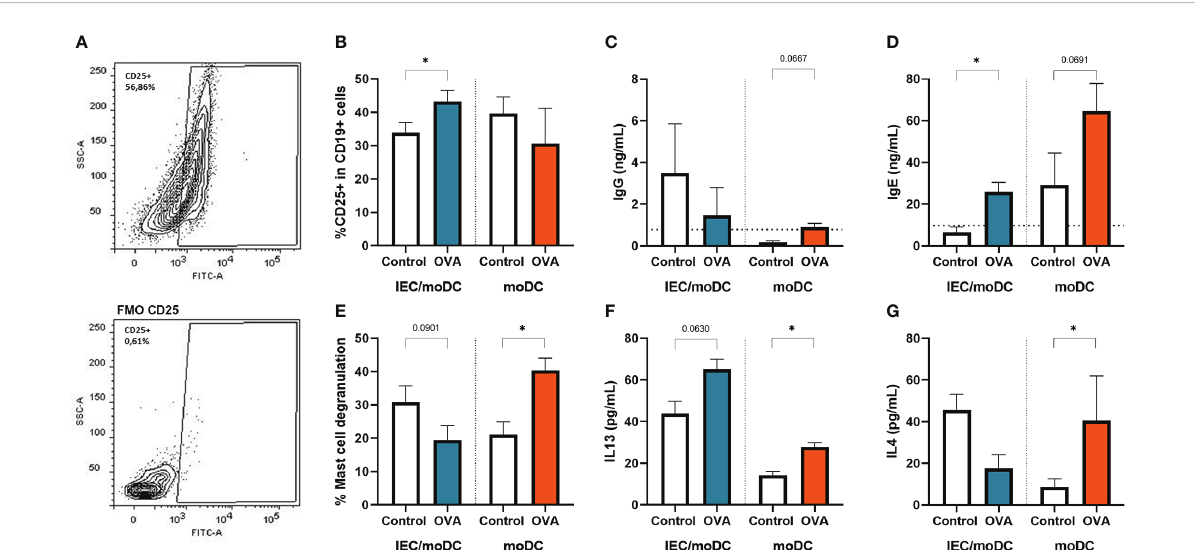
FIGURE 5 After the T cells were cocultured with OVA primed IEC-moDC or OVA primed moDC, subsequently the primed T-cells were cocultured with autologous naïve B cells. Activation of B cells was assessed at day 4 by fl ow cytometric analysis of expression of CD25, (A) a representative sample and appropriate FMO control are shown. (B) Percentage of CD25 expressing B cells are displayed for the used conditions. Secretion of (C) IgG and (D) IgE was determined in the supernatant after 18 days of coculture. These cell free 18 day supernatants were also overnight incubated with primary human mast cells. (E) Degranulation upon crosslinking with anti-IgE was determined by means of beta-hexosaminidase release as well as overnight (F) IL13, and (G) IL4 secretion by the primed and degranulated mast cells. Data is analyzed by paired t-test, n=3, mean ± SEM (*